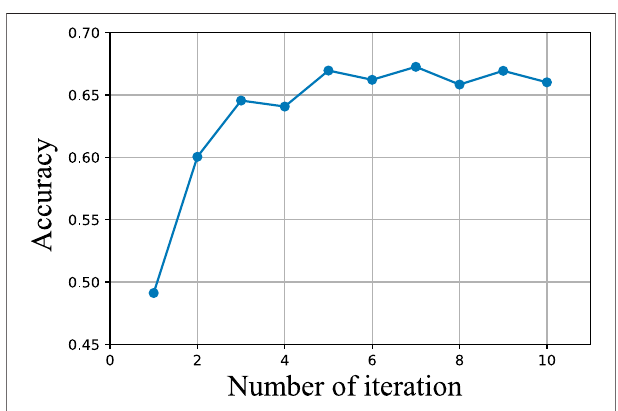
FIGURE 6 | Transition of classi fi cation accuracy of MNVAE + MLDA.